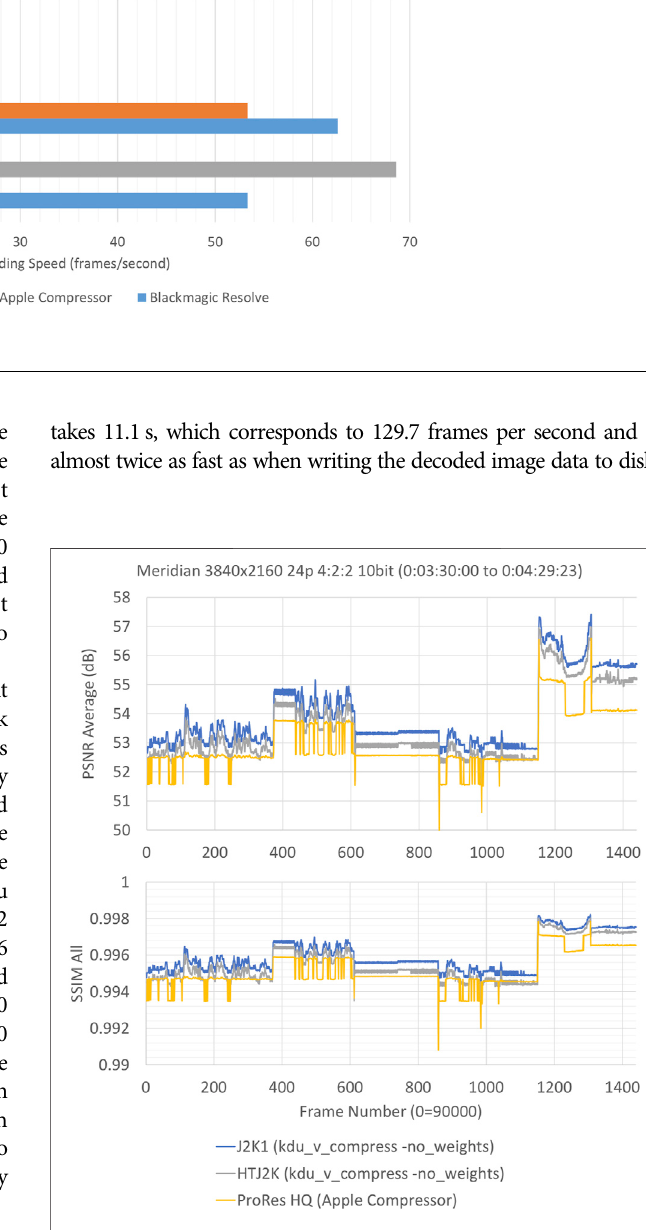
8 https://kakadusoftware.com/.